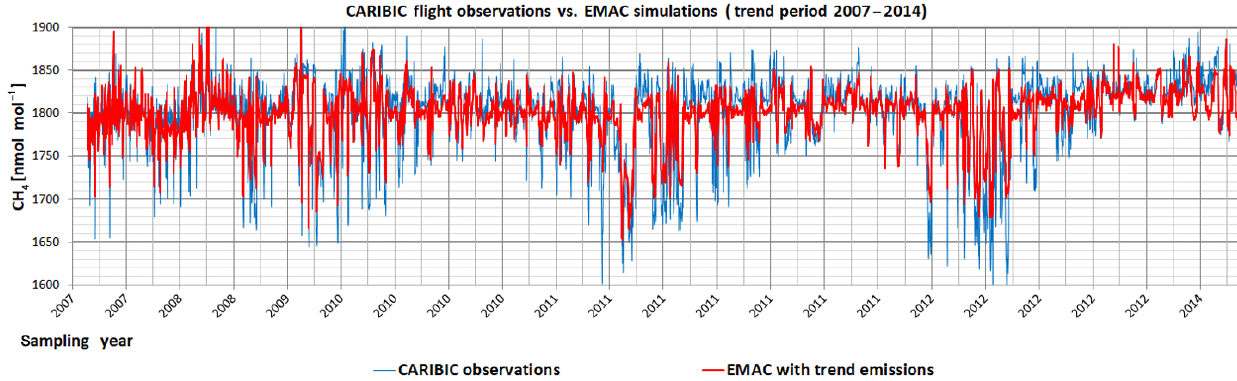
Figure 16. EMAC CH 4 calculations (red) and CARIBIC-2 observations (blue) from 2007 to 2014 – all flight